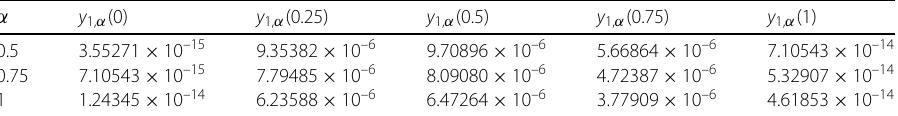
Table 7 The absolute errors of approximating y 1, α for (1,1)-system at various t and α α y 1, α (0)